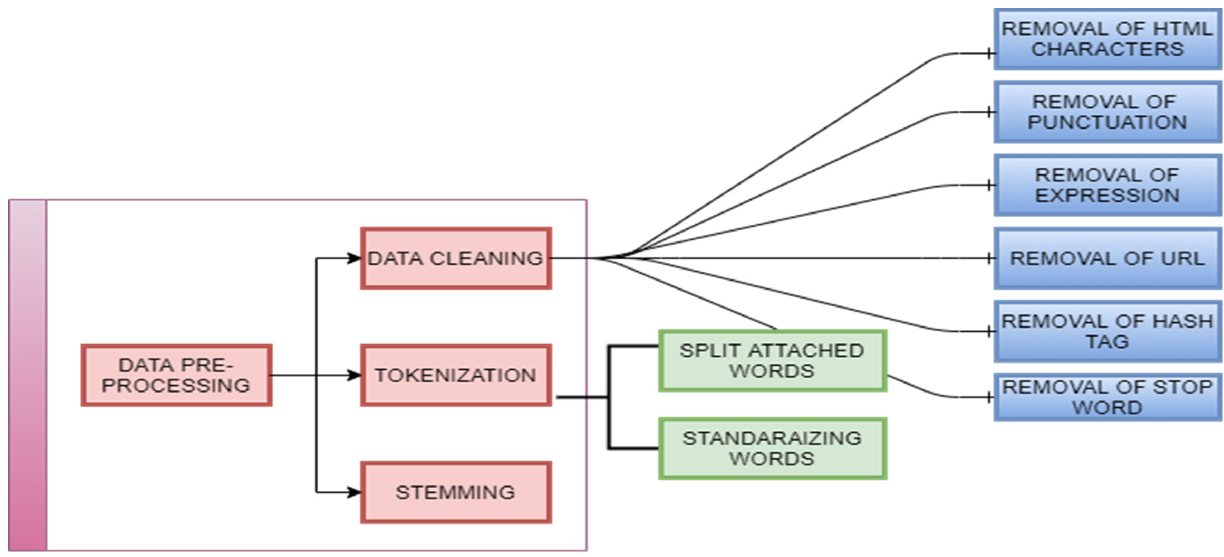
Figure 2. Framework of data preprocessing.